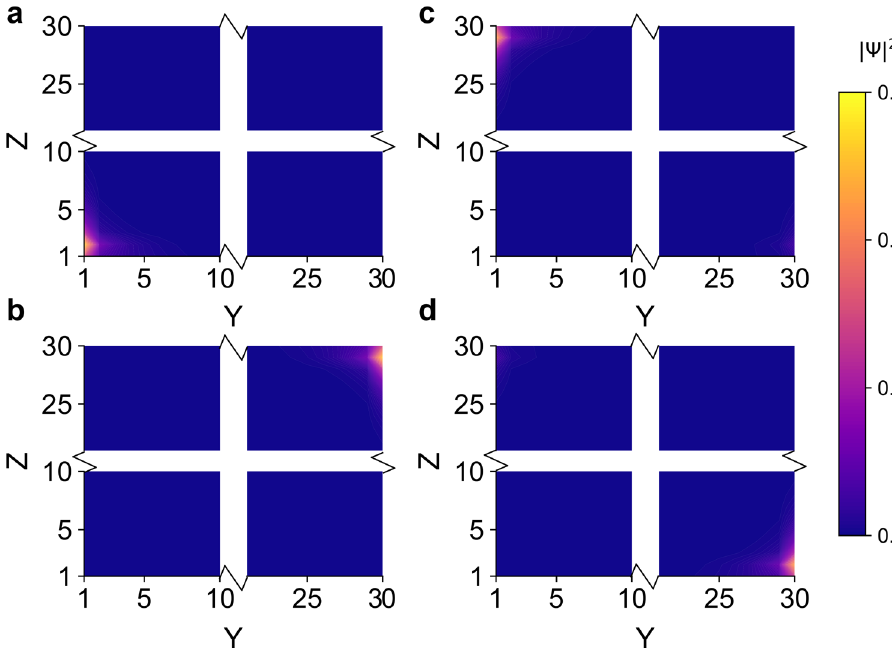
Fig. 3 Illustration of the spatial probability ∣ ψ ∣ 2 distribution of hinge states in Y-Z plane. ψ denotes the wavefunction of the state in each panel. Four states form two pairs of counter-propagating states localizing at hinges. a The hinge localized state with k x = − 0.05 π propagates in − x direction and the chirality is clockwise. b The hinge localized state with k x = − 0.05 π propagates in − x direction and the chirality is counterclockwise. c The hinge localized state with k x = 0.05 π propagates in + x direction and the chirality is counterclockwise. d The hinge localized state with k x = 0.05 π propagates in + x direction and the chirality is